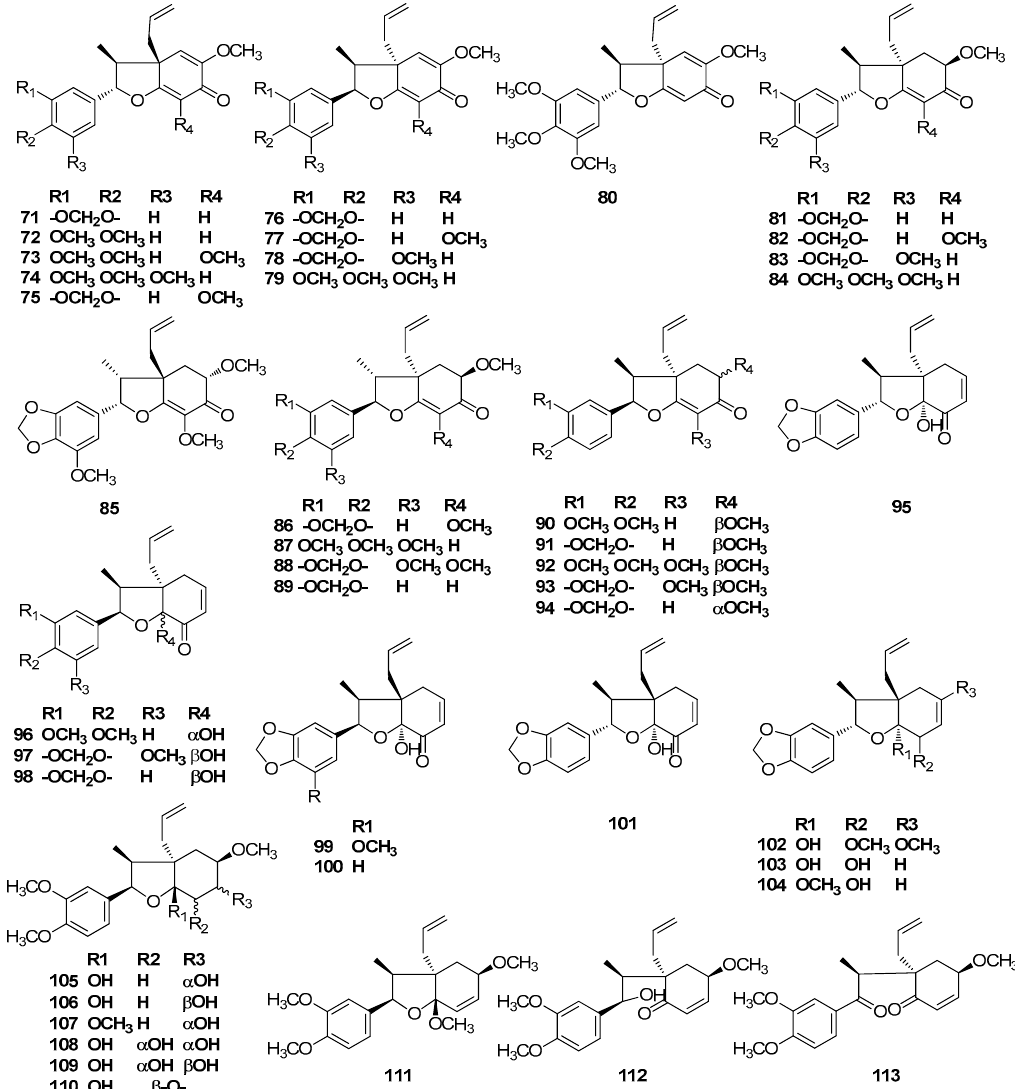
Figure 8. Chemical structures of 8,1’-neolignans.